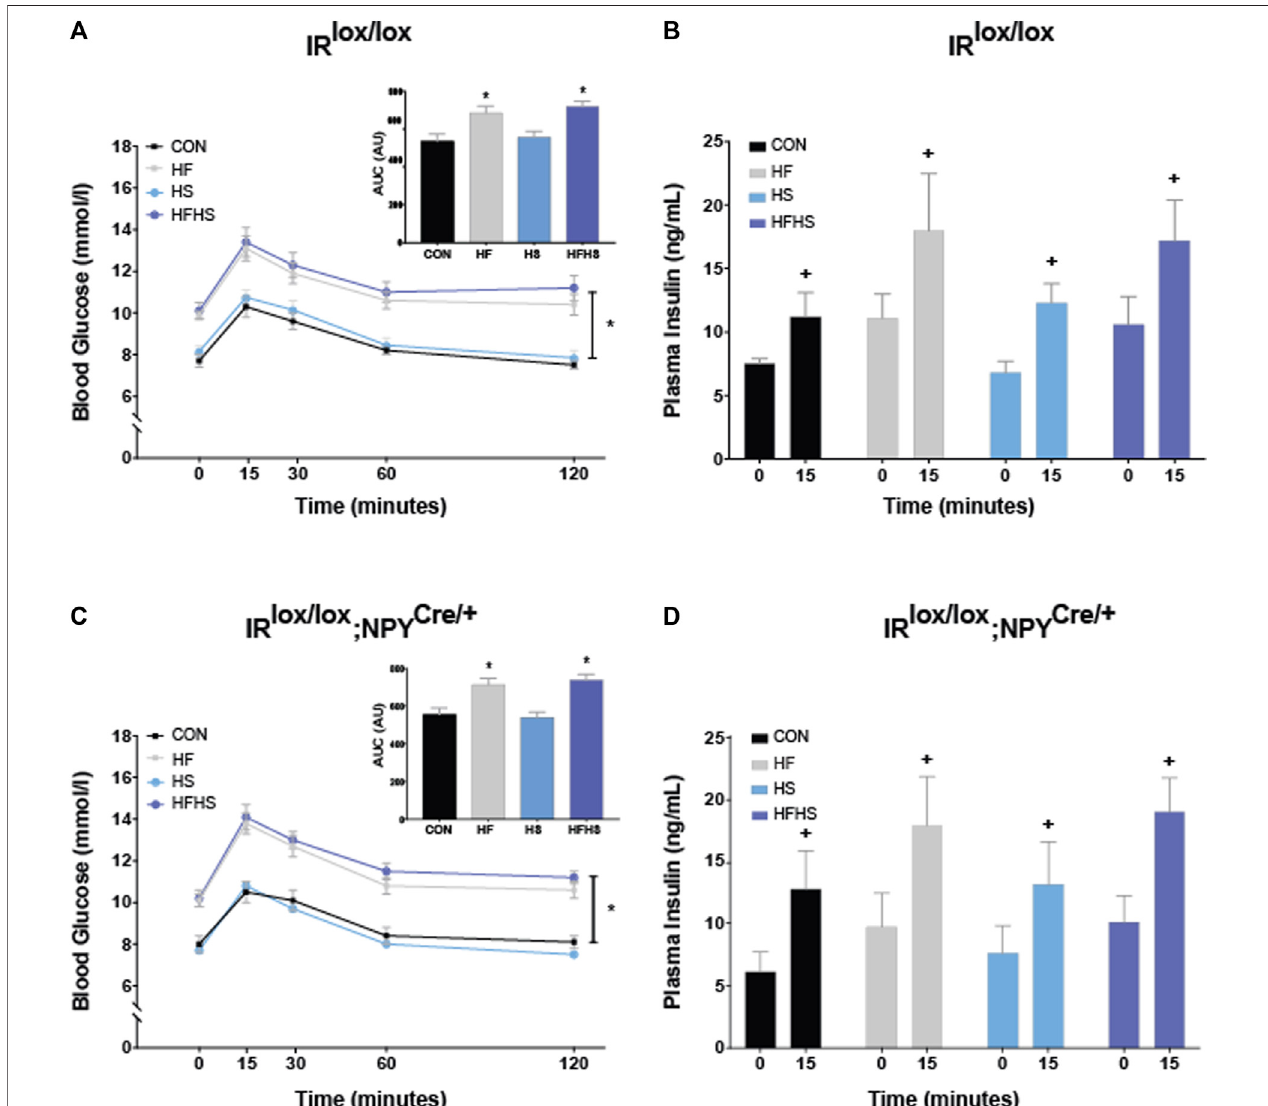
FIGURE 2 | Blood glucose and insulin. Blood glucose levels in IR lox/lox control mice in response to peripheral glucose injection over 120 min. HF and HFHS treatmentgroupsdisplayedreducedglucosetoleranceinbothIR lox/lox andIR lox/lox ;NPY Cre/+ micecomparedtoCONandHSgroups.Insetsrepresentarbitraryunits(AU) for area under the curve (AUC) values in IR lox/lox and IR lox/lox ;NPY Cre/+ mice. AUC results show a main effect of diet, with HF and HFHS treatment groups displaying increased AUC following peripheral glucose injection compared to CON and HS diet groups (A, C) . There was a within-subjects effect of time on insulin sensitivity within all dietary treatment groups in both IR lox/lox and IR lox/lox ;NPY Cre/+ mice (B, D) . CON = chow diet, HF = high fat diet, HS = high sugar diet, HFHS = high fat and high sugardiet.Valuesareexpressedasmean±SEM.+=maineffectoftime,*=p < 0.05.AnalysedbyamixedANOVA (A – D)